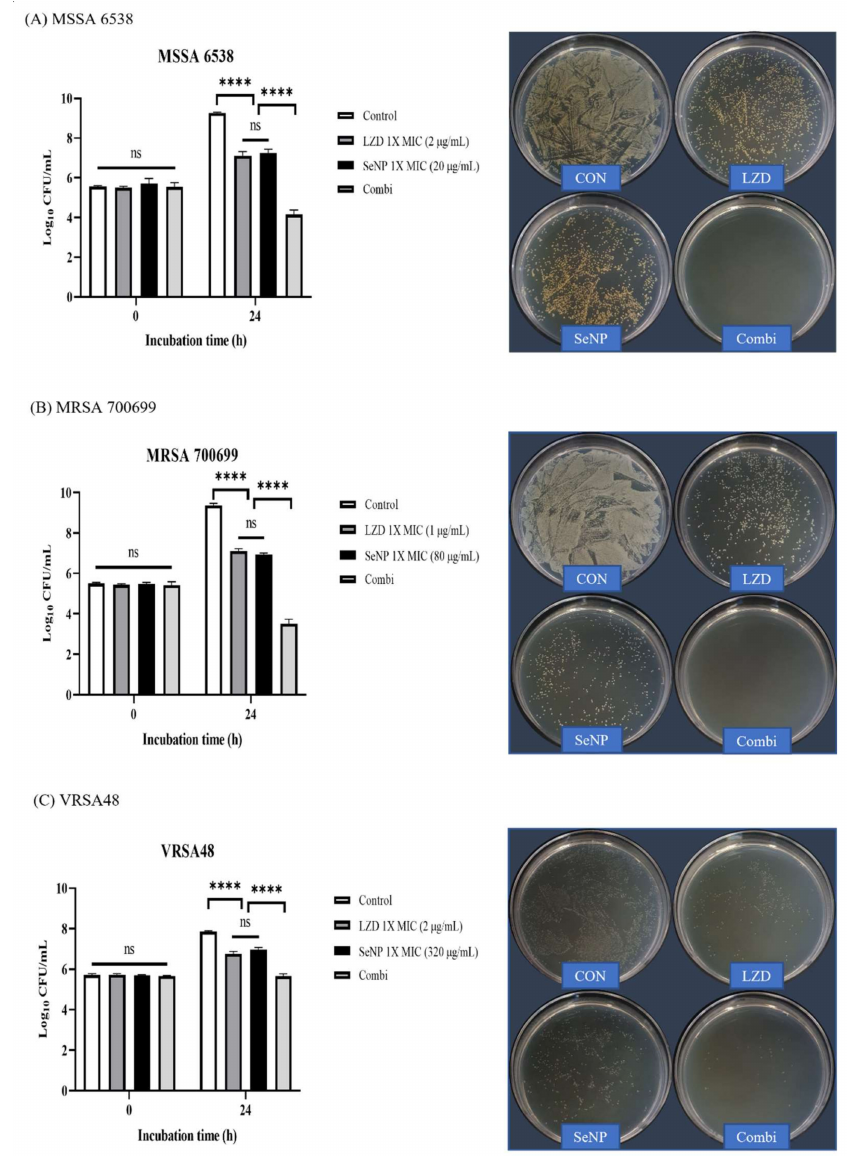
Figure 4. Synergy test and CFU assessment against MSSA, MRSA, and VRSA. ( A ) S. aureus ATCC 6538 (MSSA), ( B ) S. aureus ATCC 700699 (MRSA), and ( C ) VRSA48. The log values of CFU for each group are illustrated by the bar graphs as the mean ± SD (n = 3). The synergy tests were performed with 1 × MIC values of LZD and SeNP for each bacterium. The control was a bacterial solution without any antimicrobial agents. The Combi group was mixed so that the concentrations of LZD and SeNPs were 1 × MIC. The control was a bacterial solution without any antimicrobial agents. At 0 and 24 h, aliquots (100 µ L) were taken from each group, diluted with PBS, and spread onto MHA plates with 100 µ L of diluted solution to check the CFU. Plate images were selected as plates capable of showing the first inoculation concentration of 10 5 CFU/mL among spread plates. For MSSA and MRSA, Combi showed a synergistic effect with a decrease of greater than 3 log values compared to the single most active drug. The Combi group yielded a clean plate. For VRSA, the combi group did not differ by more than 2 log values when compared to the single treated groups, indicating an additive effect rather than a synergistic effect. In the plate images, Combi yielded relatively clean plates compared to the group treated alone. p -values were calculated using one-way ANOVA with Tukey’s multiple comparisons test in this figure. ns, not significant; **** p <